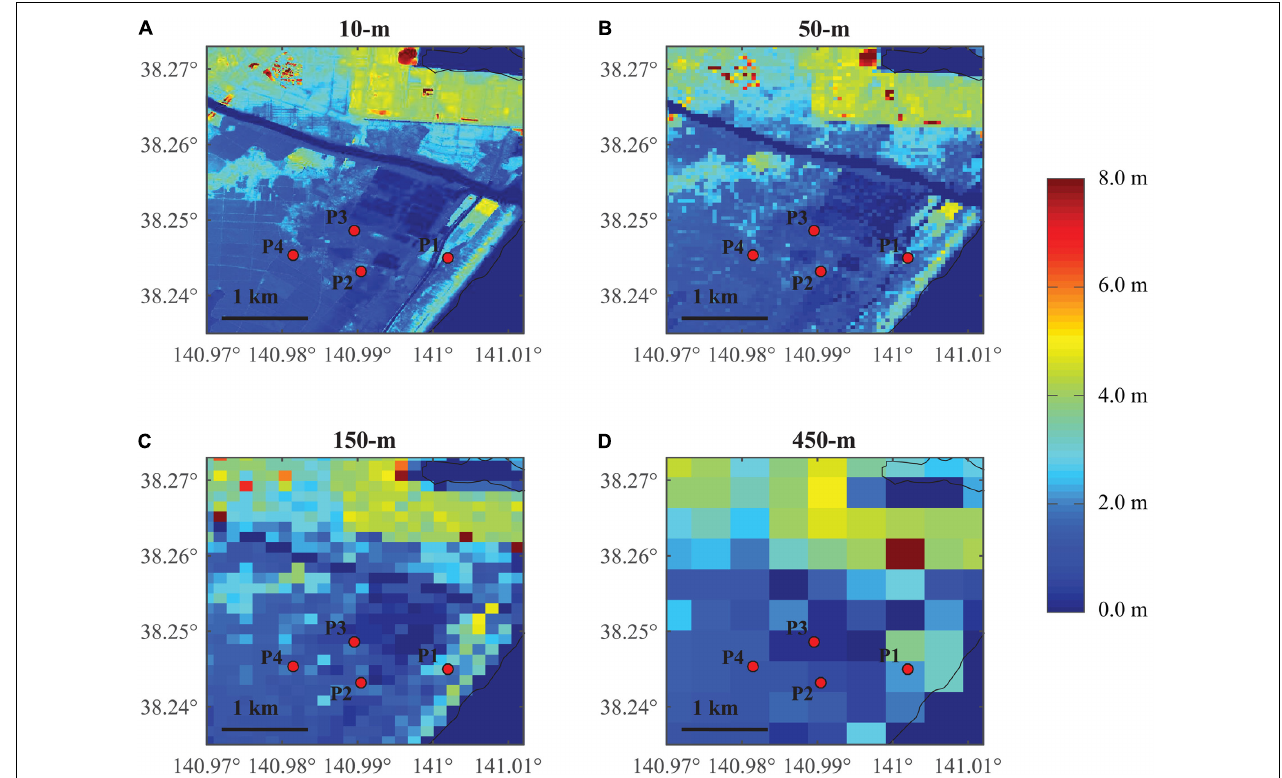
FIGURE 3 | Elevation maps for region PR1 in Sendai of different resolutions: (A) 10-m, (B) 50-m, (C) 150-m, and (D) 450-m.